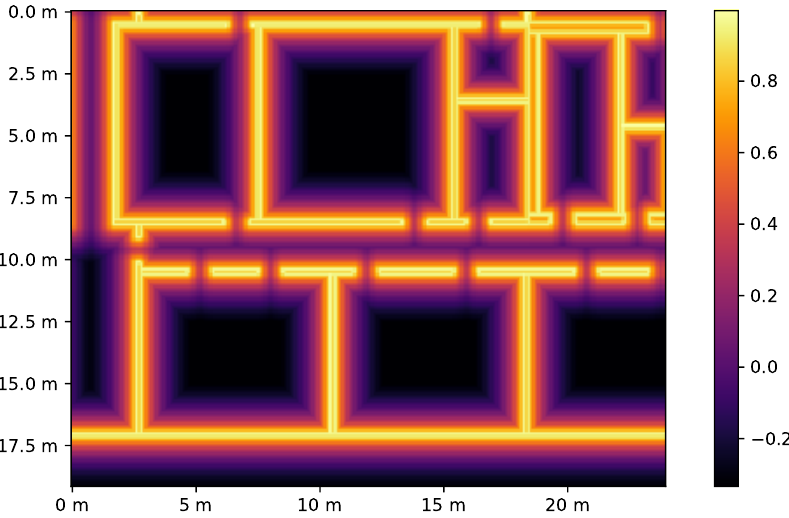
Figure 2. Inverse distance map ˆ d i , j of a Building Information Modeling (BIM)-model cross section at 1m above the floor: Higher values are closer to walls. The cutoff distance is set to 2m in this case. The same scene can be seen as a point cloud in Figure 3. Note that the value range of the map can be neglected, as the map is later used for